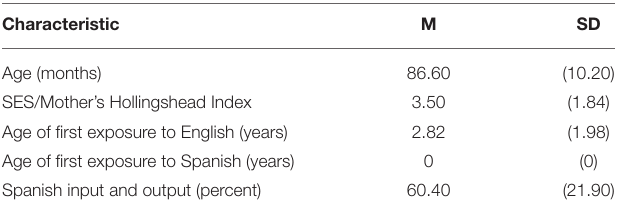
TABLE 1 | Participant characteristics presented in means and standard deviations. Characteristic